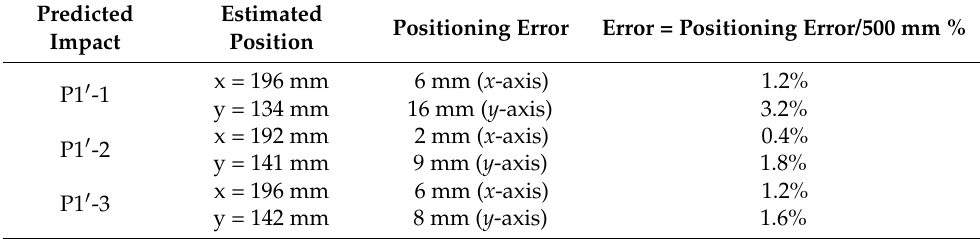
Table 2. Estimated impact positions obtained for impact P1 (cid:48) with coordinates x i = 190 mm, y i = 150 mm.